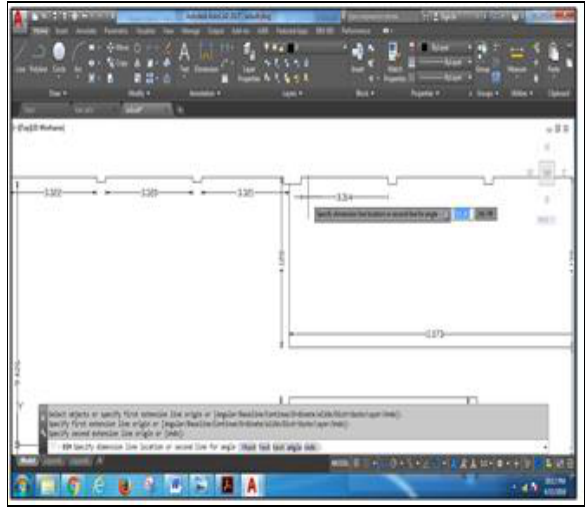
Figure 16. Dimensioning for Distometer in Autocad software